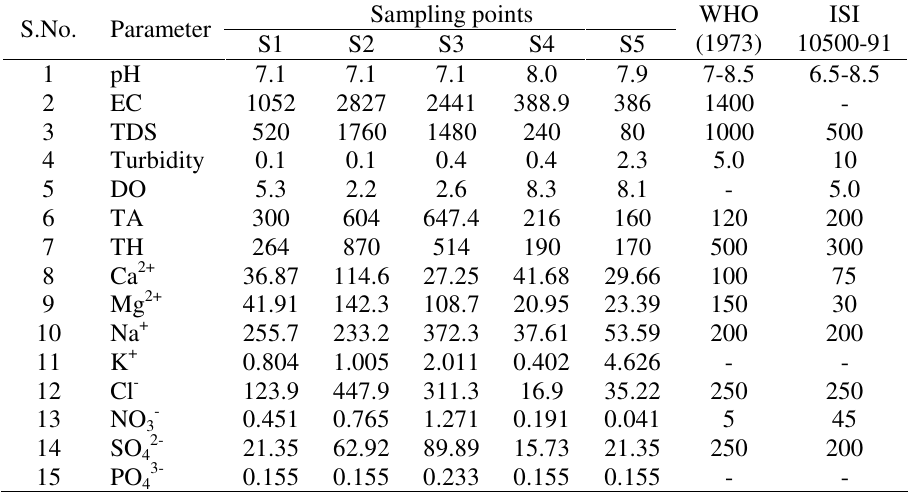
Table 2. Average results of the physicochemical parameters.